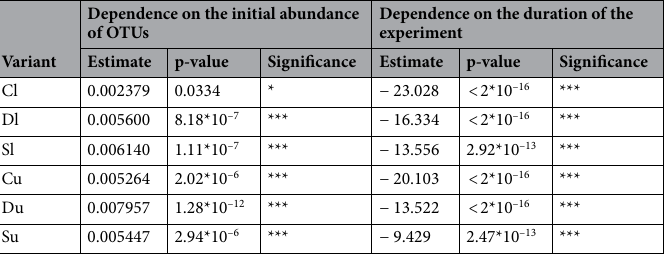
Table 2. Probability of eliminating bacterial OTUs depending on their initial abundance in unpolluted soils and on the experiment duration. *Significant (p < 0.1). ***Highly significant (p <